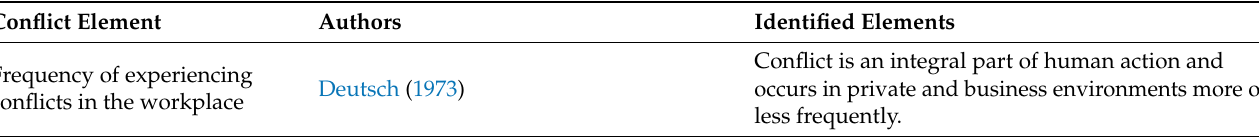
Table 1. Systematization of conflict